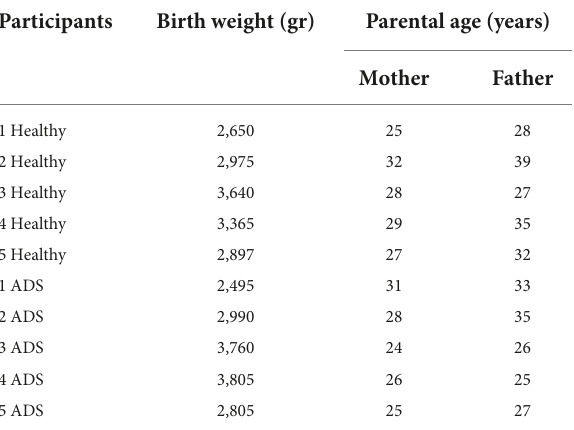
TABLE 2 Birth weight and parental